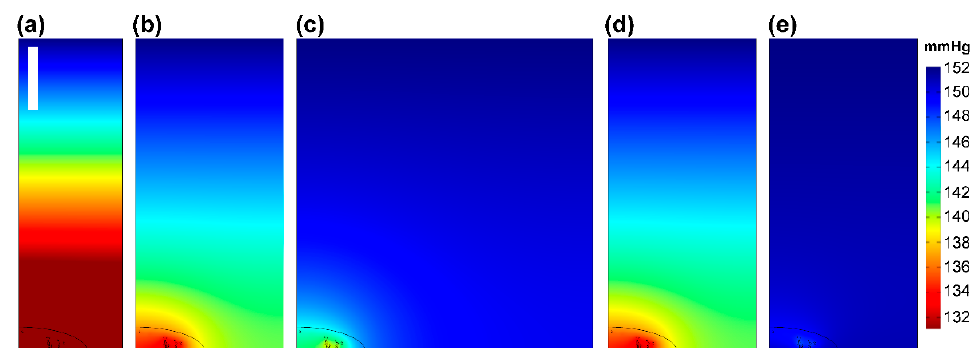
Figure 4. Confluence and substrate effects. The pO 2 (mmHg) slices of model with glass lower boundary at equilibrium with cell spacing of ( a ) 70 μ m, ( b ) 100 μ m, and ( c ) 200 um, and with 100 μ m spacing but lower boundary of ( d ) Ibidi polymer or ( e ) 200 μ m PDMS, each over atmosphere. Planes through y = x (i.e., diagonal to the square grid, in order to show longer dimension, shown by dotted line in Figure 3a). All panels are the same geometric scale; the scalebar in ( a ) is 30 μ m. All panels are in the same color scale, as per bar at right.